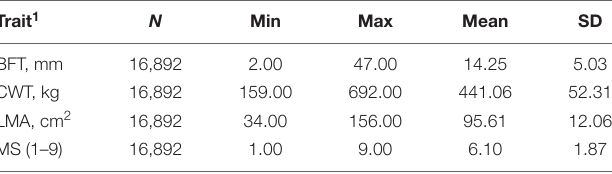
TABLE 1 | Descriptive statistics for carcass traits in Hanwoo cattle. Trait